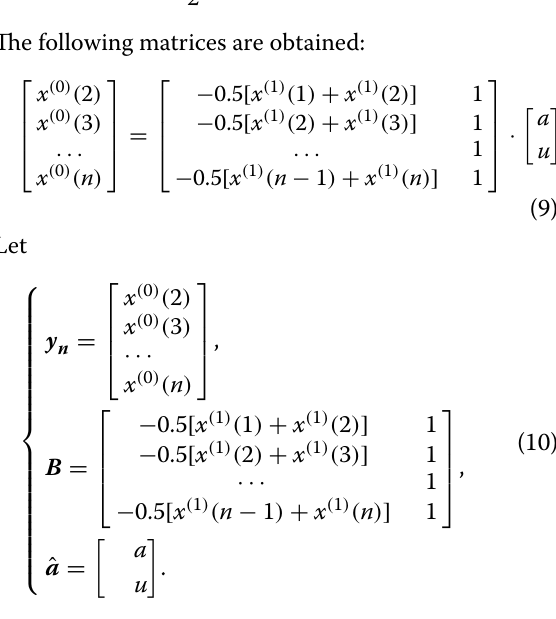
Solving the Grey parameters by the least squares method, we obtain